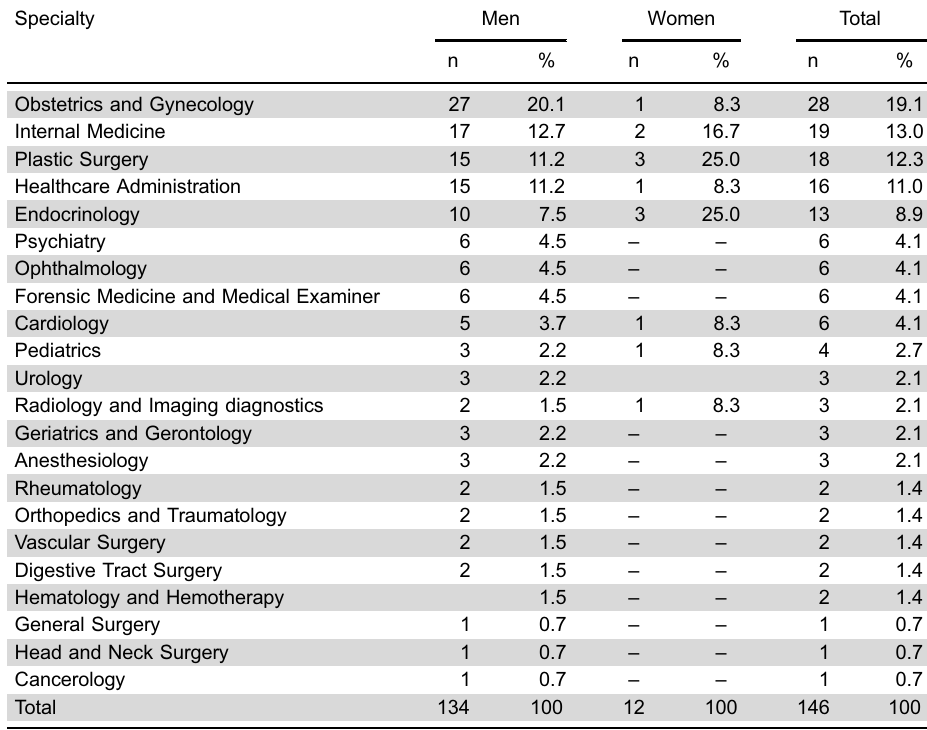
Data are reported as number and percent of n=146.